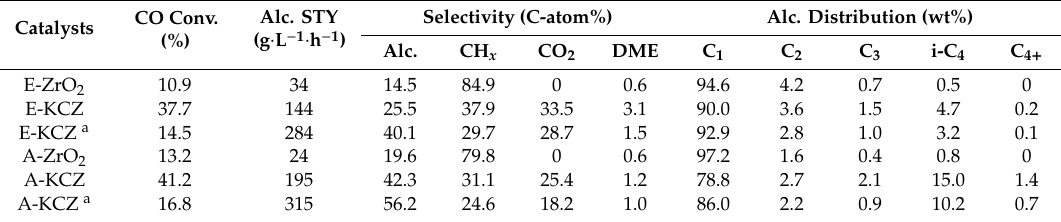
Table 2. The catalytic performance of ZrO 2 -based